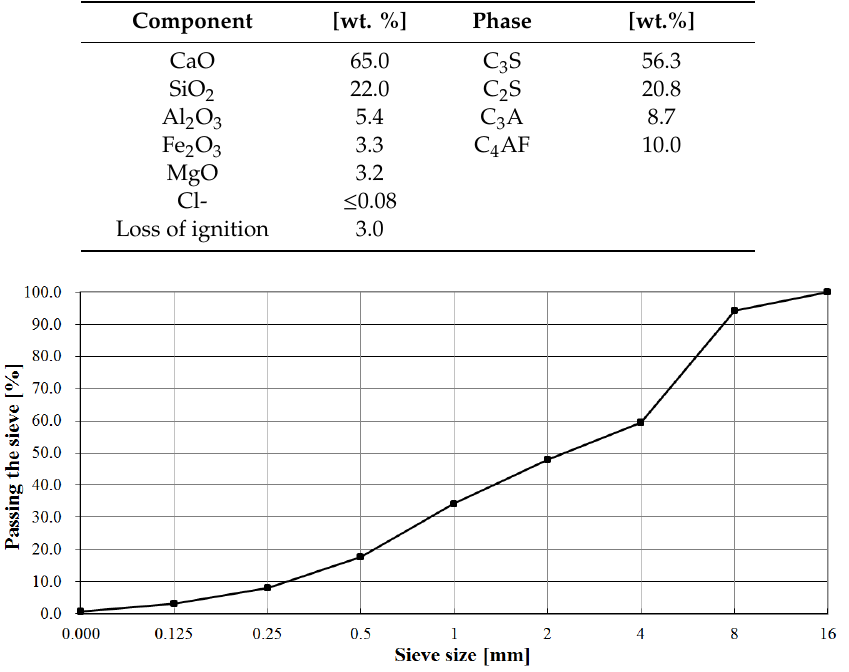
Figure 1. Grading curve of the aggregate.